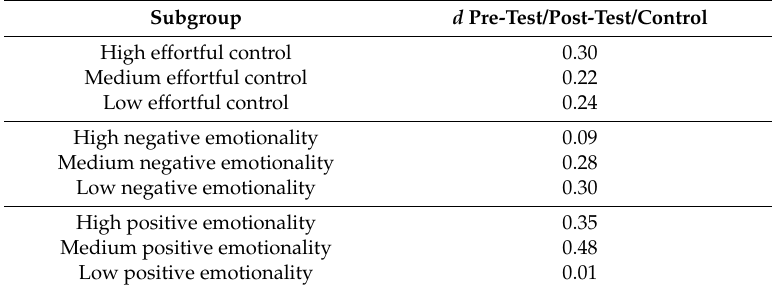
Table 3. Effect sizes (Cohen’s d ) estimates from pre-test/post-test/control group designs in each temperamental